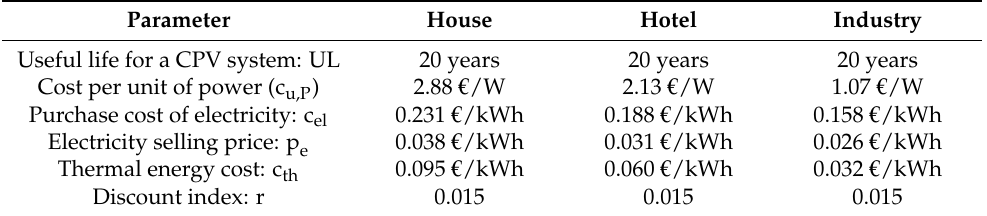
Table 4. Values of the parameters used in the sizing of the CPV/T systems for the three users [28,29]. Parameter House Hotel Industry